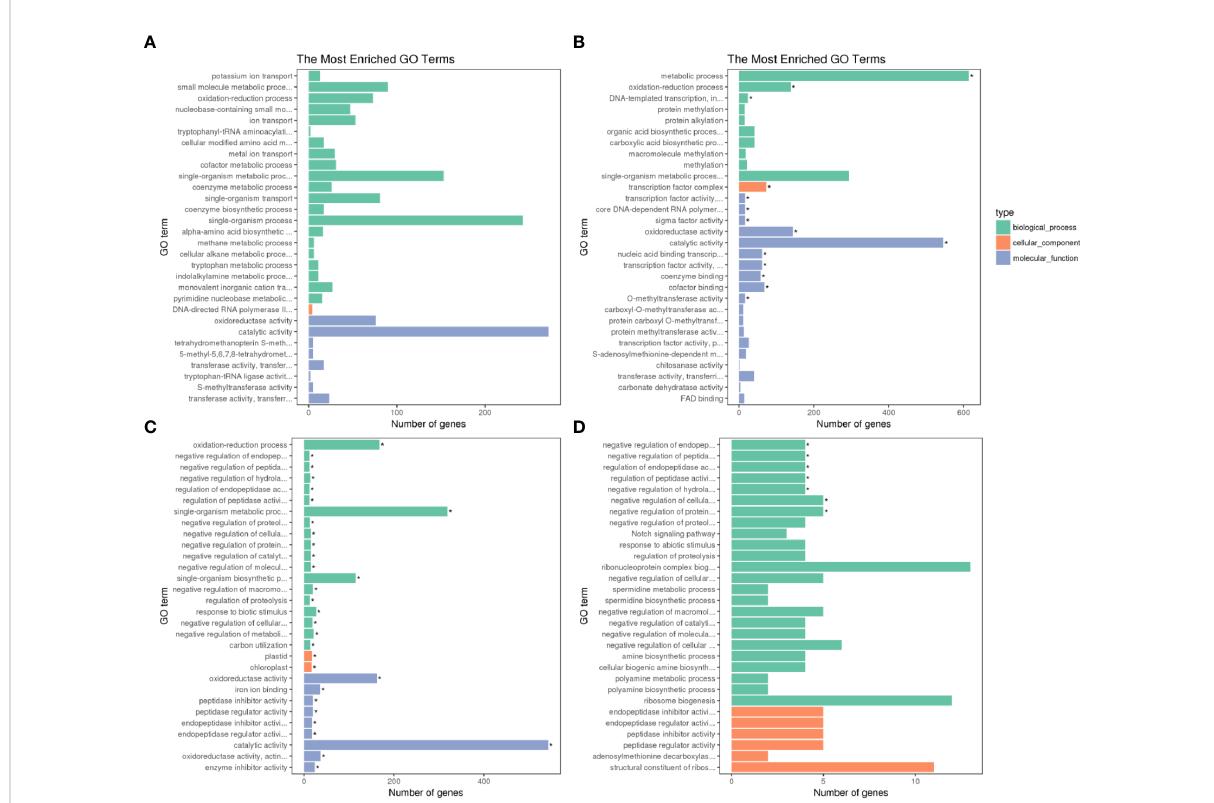
FIGURE 3 GO categorization of the DEGs. DEGs were separated into metabolic categories based on biological processes, cellular components and molecular functions. GO categorization of the DEGs in N4 (A) , N8 (B) , M4 (C) , and M8 (D) . N4 and N8 represent the comparison groups of the genes identi fi ed at 4 h and 8 h after treatment in Adina. M4 and M8 represent the comparison groups of the genes identi fi ed at 4 h and 8 h after treatment to 0 h in Zhaodong. *Asterisk means DEGs were signi fi cantly enriched in this GO